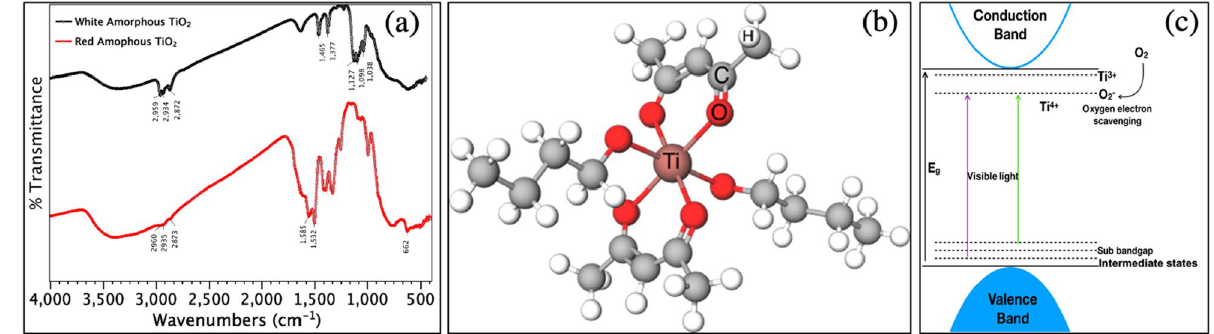
Figure 2. Oxygen vacancy-rich (red) amorphous TiO 2 , structure and properties. ( a ) Comparison of the FTIR absorption spectra for the standard (white) and the vacancy-rich (red) amorphous TiO 2 . ( b ) Schematic representation of the Ti(OBu) 4 molecule chelated by acetylacetone (acac) during the synthesis. ( c ) Schematic representation of the energy diagram with sub-bandgap states due to oxygen vacancies, explaining the dark color. The proposed reaction for the laser-assisted phase transition process is also